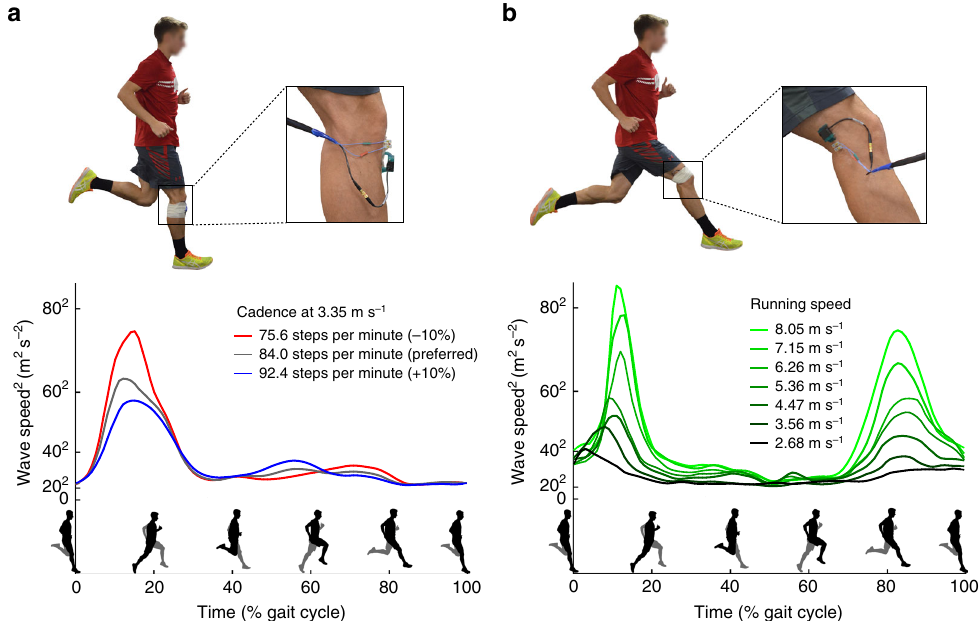
Fig. 5 Running experiments. a Patellar tendon wave speeds speed over the gait cycle when running at a fi xed speed with different step rates. b Lateral hamstring (biceps femoris) tendon wave speeds detect utilization of this muscle with increasing speed during both mid-stance (15% of gait cycle), and late swing (85% of gait cycle). Hamstring loading during both phases increased markedly with speed, though stance phase demands greater tissue loads than swing phase in this